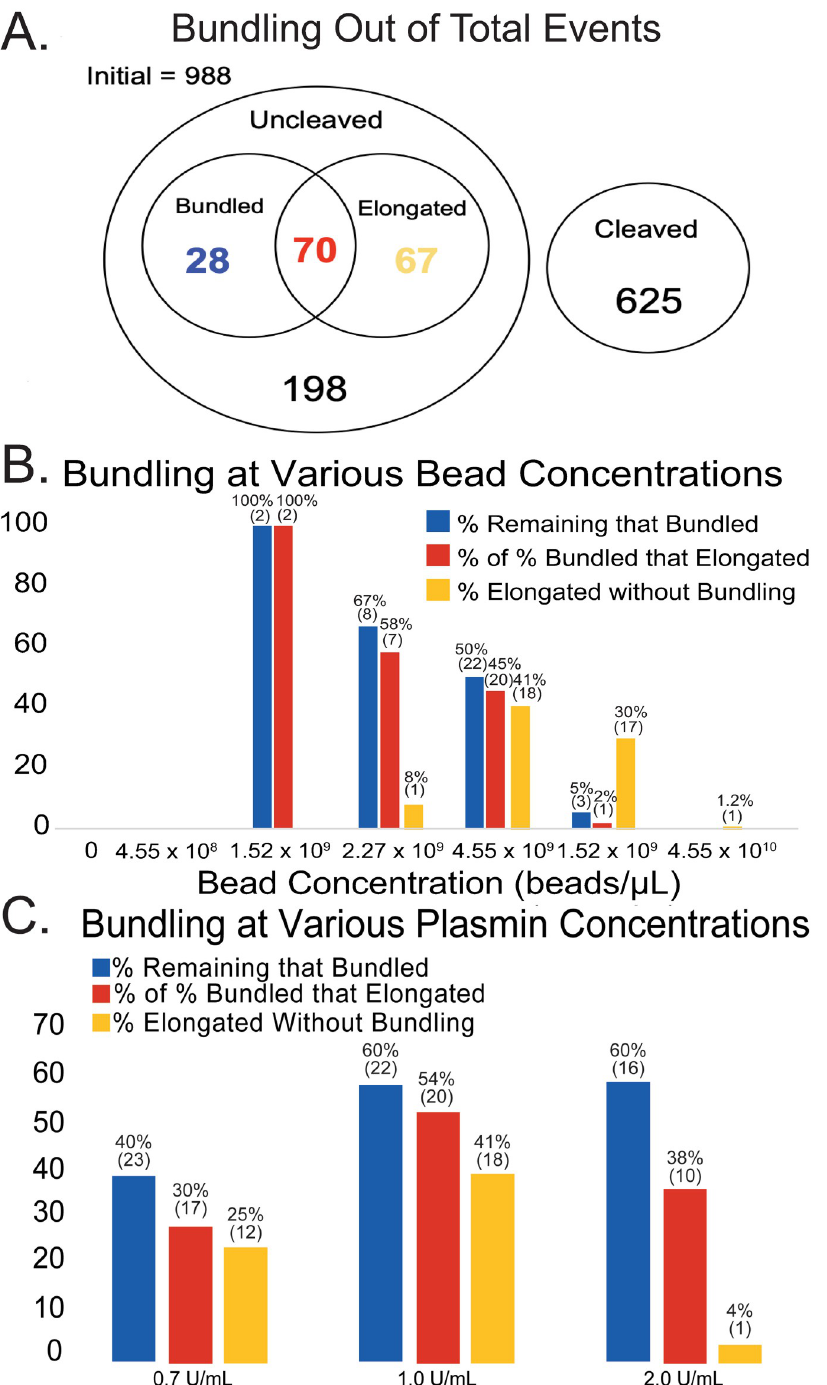
Fig 4. Bundling events. (A) A Venn Diagram displaying how many fibers were cleaved and uncleaved and of the uncleaved fibers, how many were bundled and straight (blue), bundled and elongated (red) and elongated (yellow). (B) Plot displaying bundling as a function of bead concentration. Blue bars denote the percentage of uncleaved (remaining) fibers that bundled, red bars show the percentage of uncleaved fibers that bundled and elongated, and yellow bars represent the percentage of uncleaved fibers that elongated without bundling. (C) Bar plot displaying bundling data broken down by plasmin concentration. Note that in all panels, fibers comprising the red bars are a subset of the fibers comprising the blue